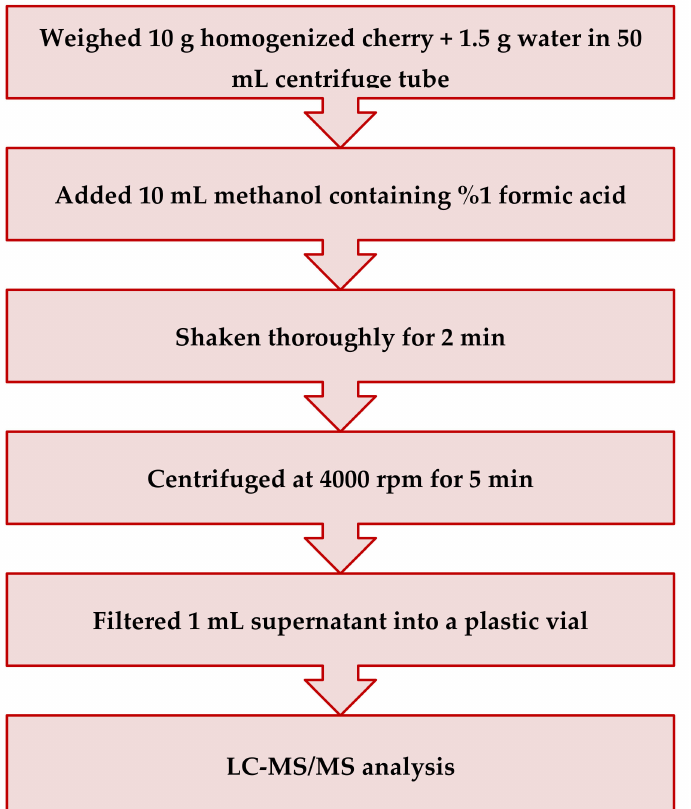
Figure 4. The schematic diagram of the QuPPe method. Electrospray negative ionization (ESI-) was used for the monitoring of the twelve highly polar compounds and the four ILISs. The multiple reaction monitoring (MRM) settings for each polar compound were optimized by infusing neat standard solutions. The parameters for each target analyte’s MRM transition are given in Table 3. Table 3. MS/MS parameters for the analysis of target polar compounds in the MRM ESI-negative mode.